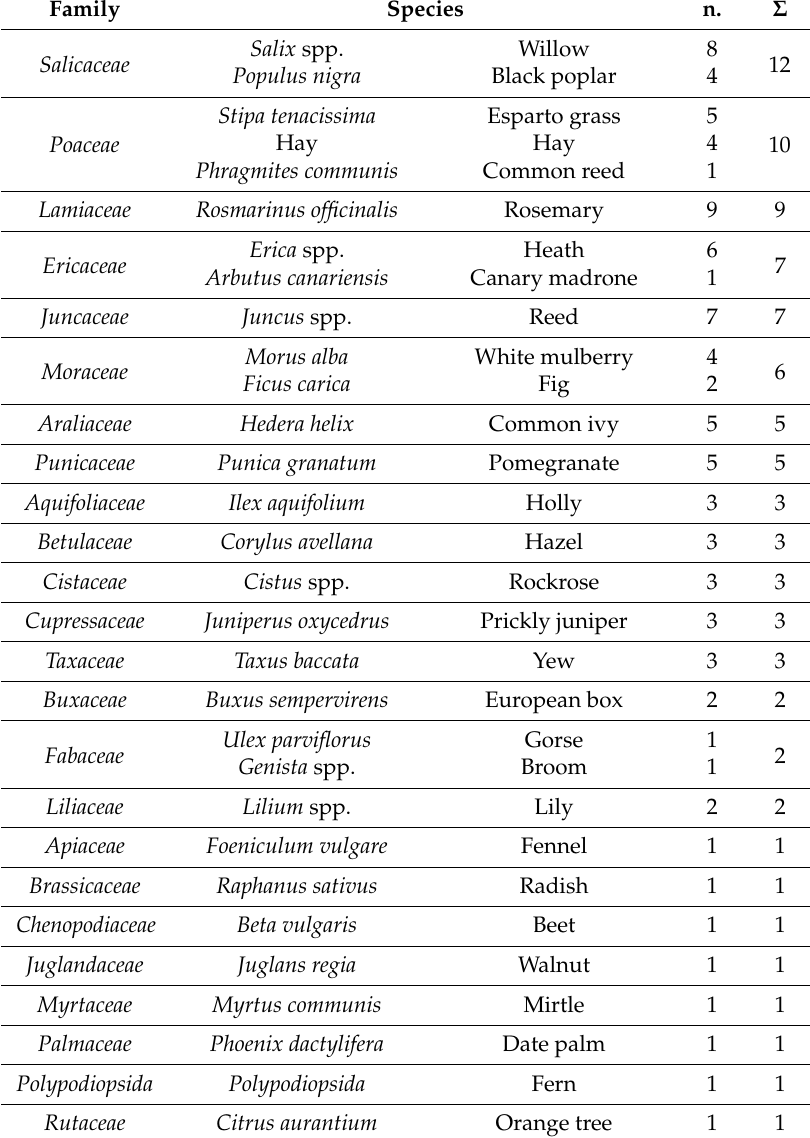
Table 3. Marian verdant advocations in Spain (n <